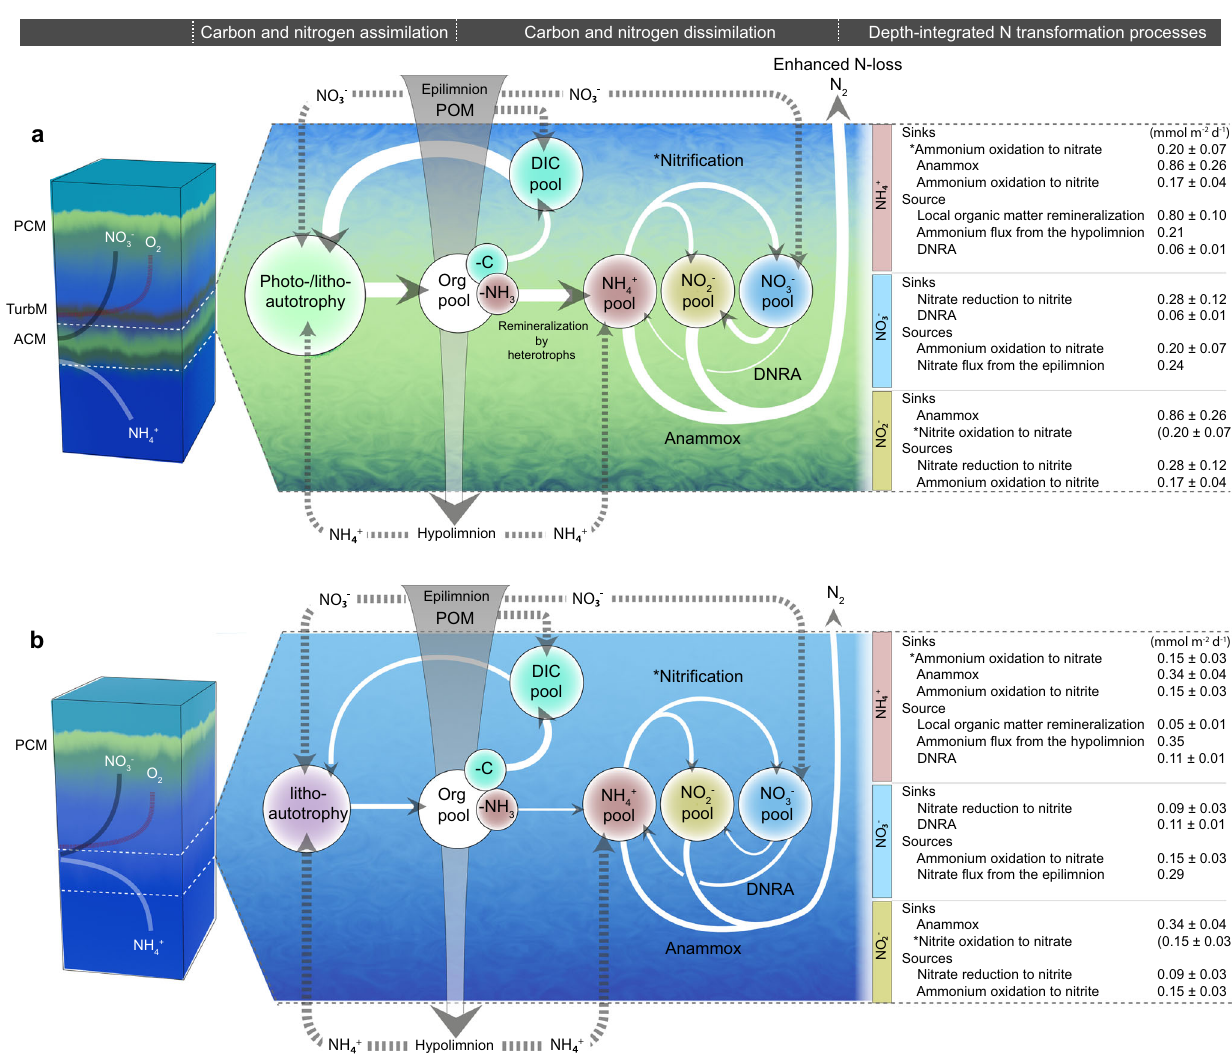
Fig. 3 Conceptual model of carbon and nitrogen transformation processes in the presence and absence of the anoxic chlorophyll maximum (ACM). The Lake Tanganyika schematic represents a synthesis of ideas from measurements performed at station 2 (ACM scenario) and at station 7 (non-ACM scenario) in panels a and b , respectively. The phototrophic community in the ACM comprised mainly of green sulfur bacteria (21.6%) and to a lesser extent by Synechococcales (1.4%; Supplementary Fig. S2b, c). Lithoautotrophic activity might also co-occur in the ACM as a result of the various nitrogen cycling processes (Supplementary Fig. S2e, k). Abbreviations are as follows: PCM primary chlorophyll maximum, TurbM turbidity maximum associated with the